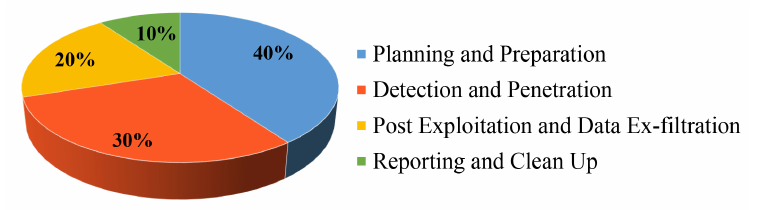
Figure 1. Penetration test phases—effort and time distribution.